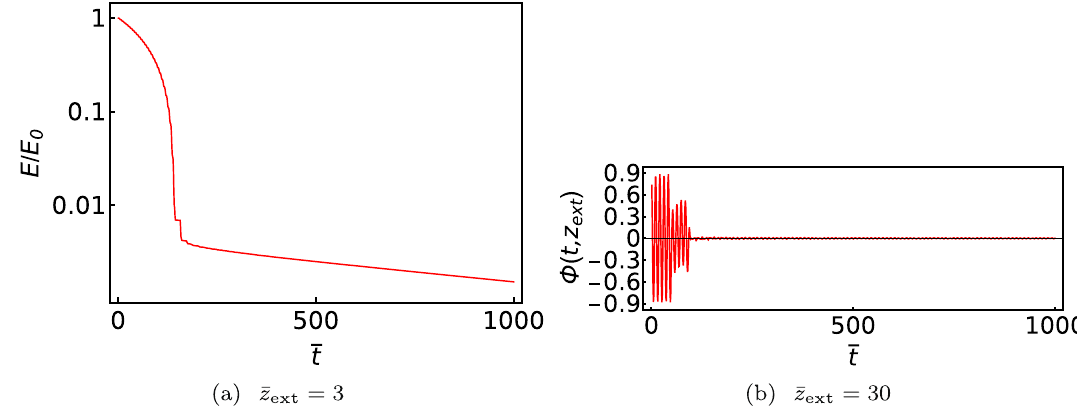
Fig. 5 Left panel: The energy of the scalar field vs. time for the evolution of nonresonance for ¯ b = 15. Right panel: Time evolution of the nonresonance with ¯ z ext = 30 for ¯ b =